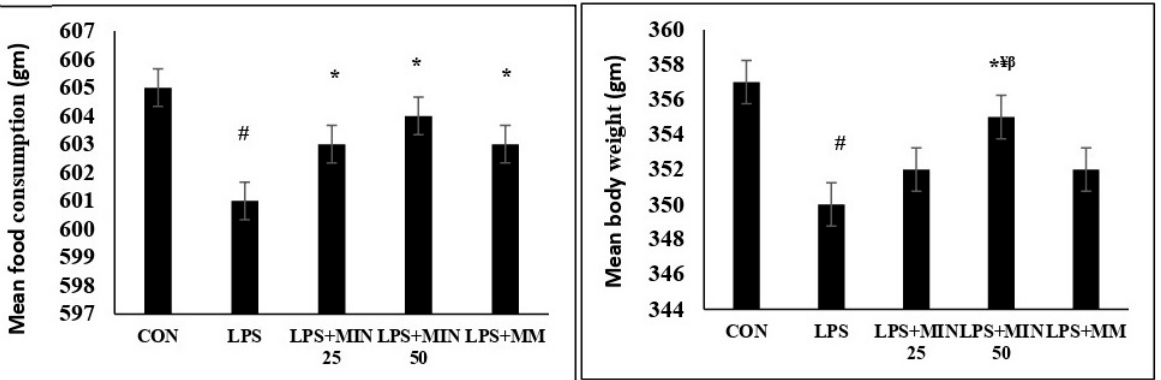
Figure 1. Mean food intake and body weight for all groups. One-way ANOVA test followed by Bonferroni post hoc test. Values are expressed as mean ± SEM. n = 10. (F (1, 36) = 6.34; # p < 0.05) versus control group; (F (1, 36) = 7.39; * p < 0.05) versus LPS group, (F (1, 36) = 12.10; ¥ p < 0.05) versus MIN 25, (F (1, 36) = 5.17; β p < 0.05) versus MM.